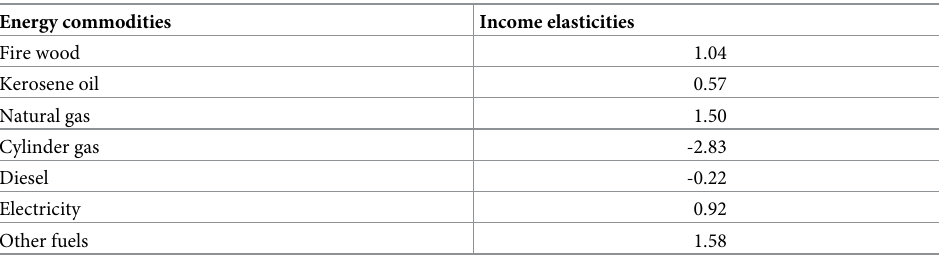
Table 14. The income elasticities from LA-AIDS models.